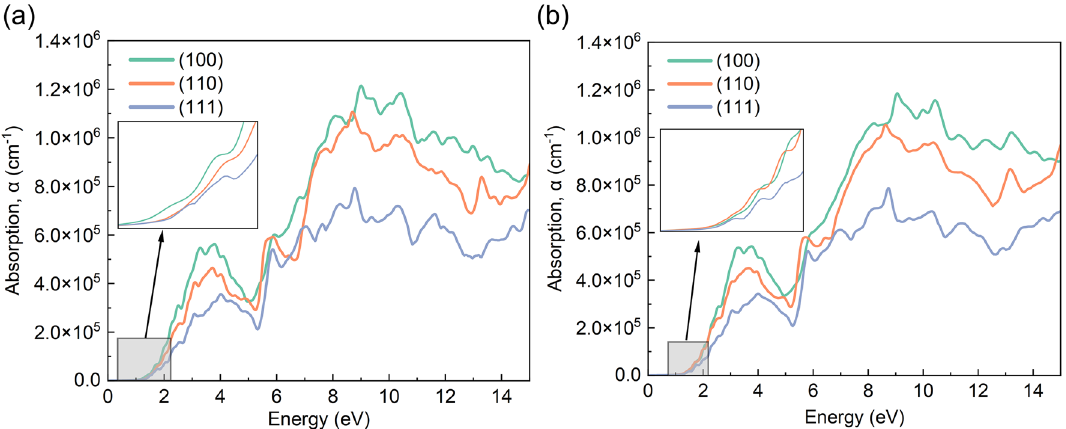
Figure 8. Optical adsorption spectrum of perovskite structures of ( a ) FAPbI 3 and ( b ) FA 0.875 Cs 0.125 PbI 3 with different FA cations